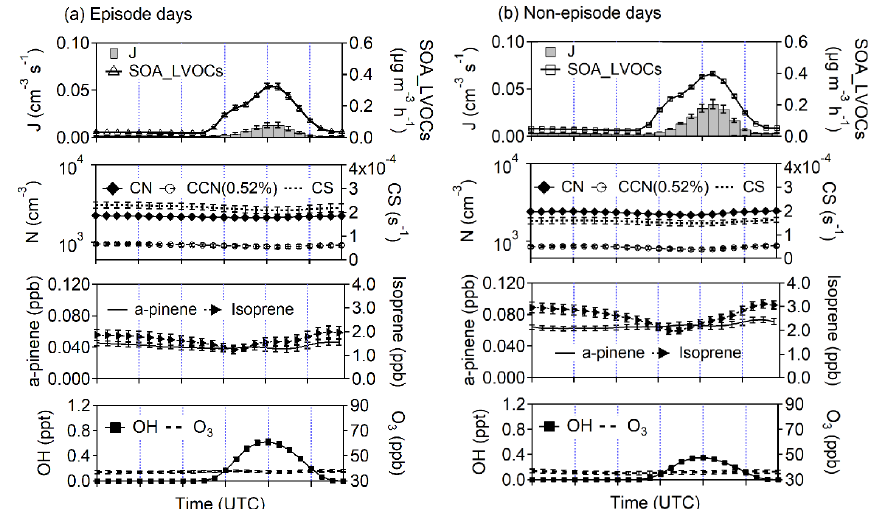
Figure A14. Same as Fig. 4b and c, but for the planetary boundary layer (PBL).